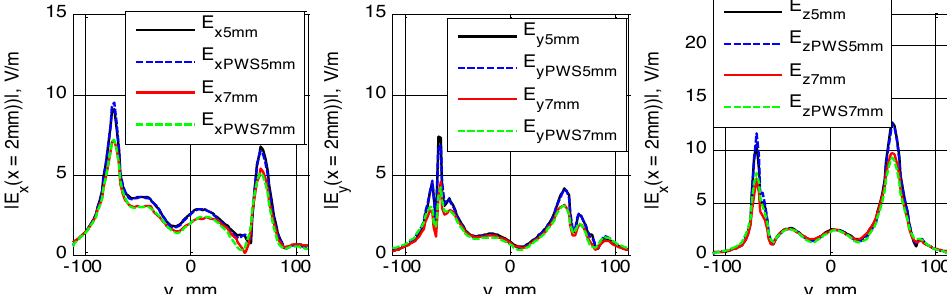
Figure 9: Comparisons of the E-field profiles computed directly from the analytical defintion and from the PWS method proposed at z = 5 mm and z = 7 mm.